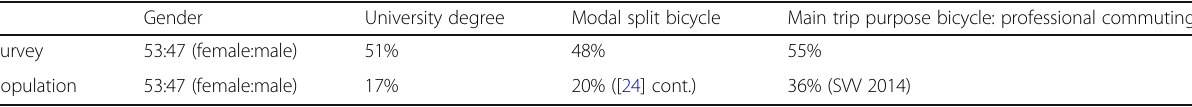
Table 2 Characteristics of participants (reference data from Statistics Austria or referred sources) Gender University degree Modal split bicycle Main trip purpose bicycle: professional